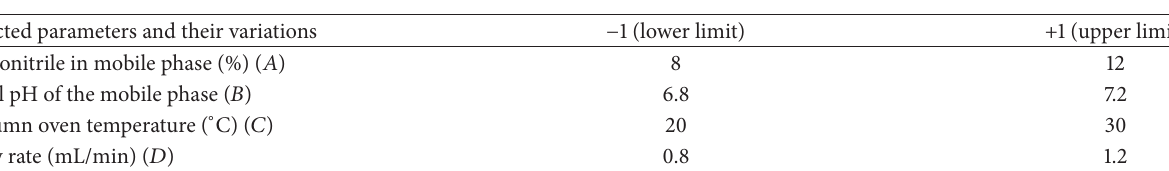
Table 5: Factorial design data for robustness of chromatographic separation.